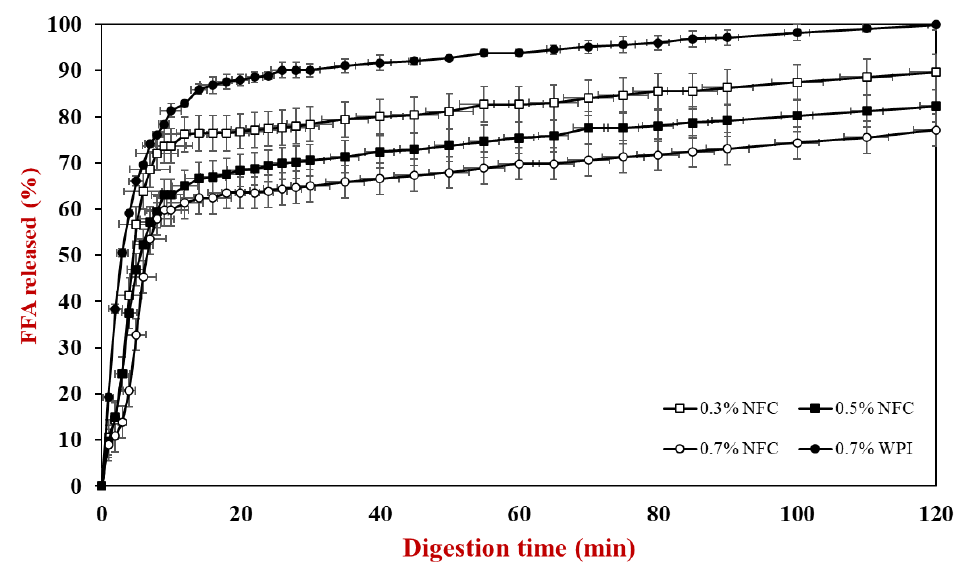
Figure 5. Release of free fatty acids (FFAs) from AX-loaded emulsions under small intestine conditions prepared with various emulsifiers containing nanofibrillated cellulose and whey protein.